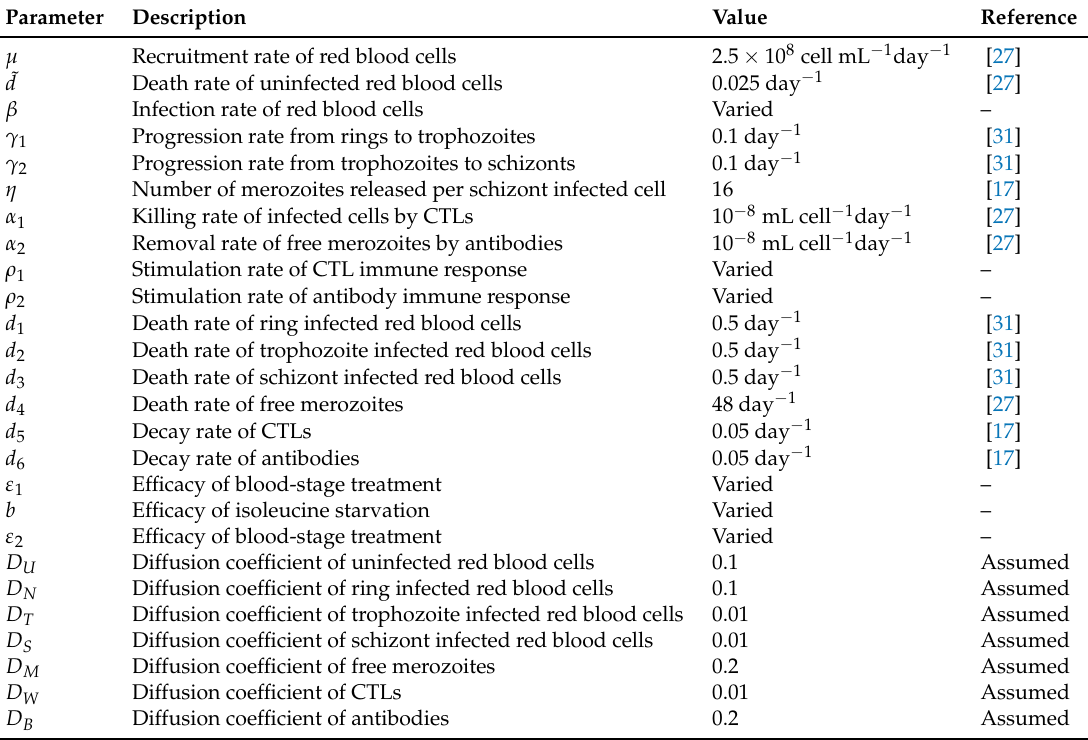
Table 1. Parameters values of model